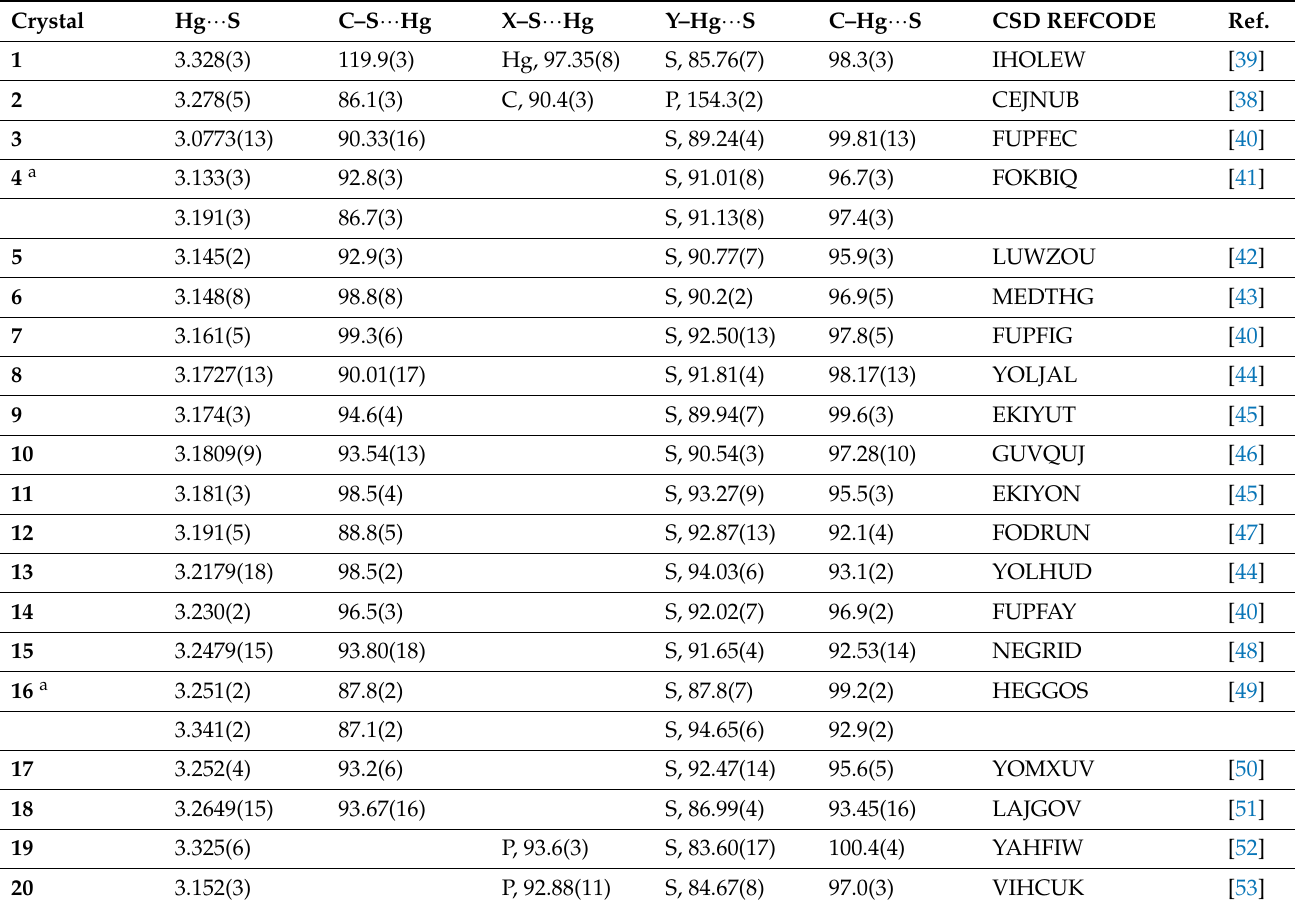
Table 1. Summary of key geometric parameters (Å, ◦ ) for zero-dimensional aggregates 1 – 20